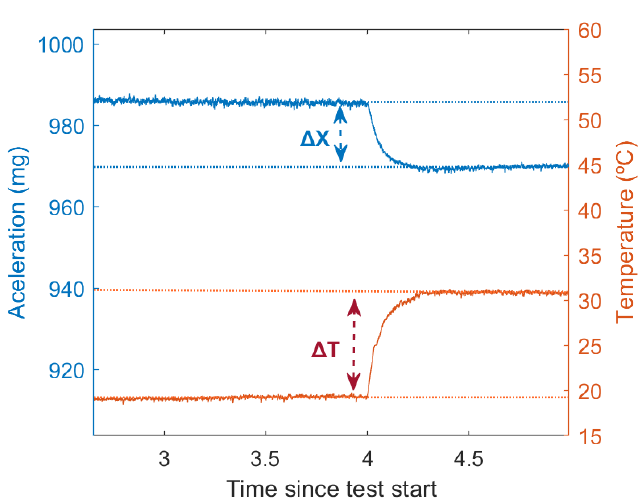
Figure 10. Values extracted for the TD X computing for one step. 0 If the temperature variations between the steps were too low, the acceleration varia- tions would also be low, and Equation (11) would approximate to 0/0. The noise of both signals would lead to incorrect data that does not represent the sensors behavior. In our case, all the temperature variations exceed 10 ◦ C and are considered